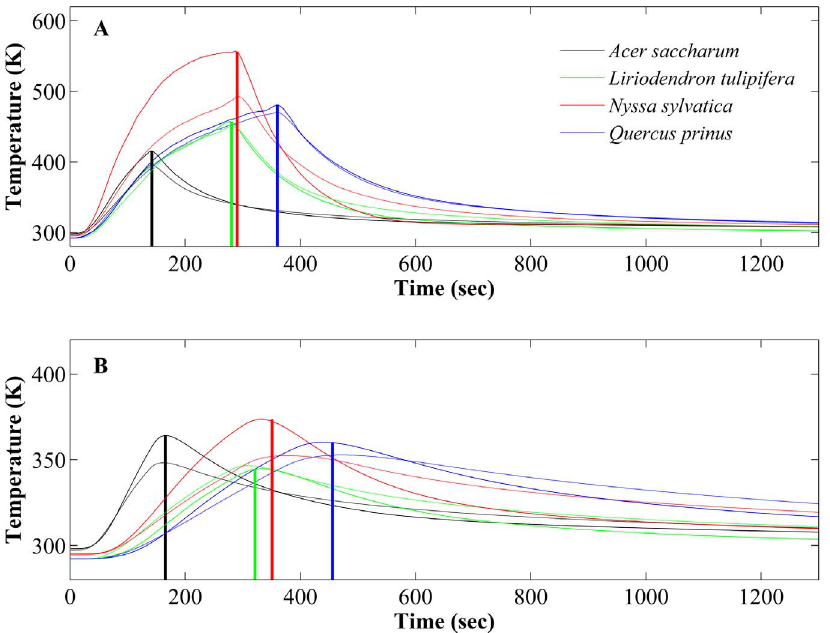
Figure 3. Comparison of laboratory observations and FireStem2D simulations of temperature variation through time for four tree species at different locations in the stem section. A. Just beneath surface. B. At the cambium. Solid curves mark FireStem2D simulation results and dashed curves mark laboratory observations. Bold vertical lines in each time series marks the observed timing of peak heating, and defines the end of the heat-up phase, and start of the cool-down phase, afterwards. Different color signifies different tree species. Black: Acer saccharum ; green: Liriodendron tulipifera ; red: Nyssa sylvatica ; and blue: Quercus prinus. These are examples from the 52 tree sections collected from 25 trees of 8 different species that were tested in the laboratory (Table 1).